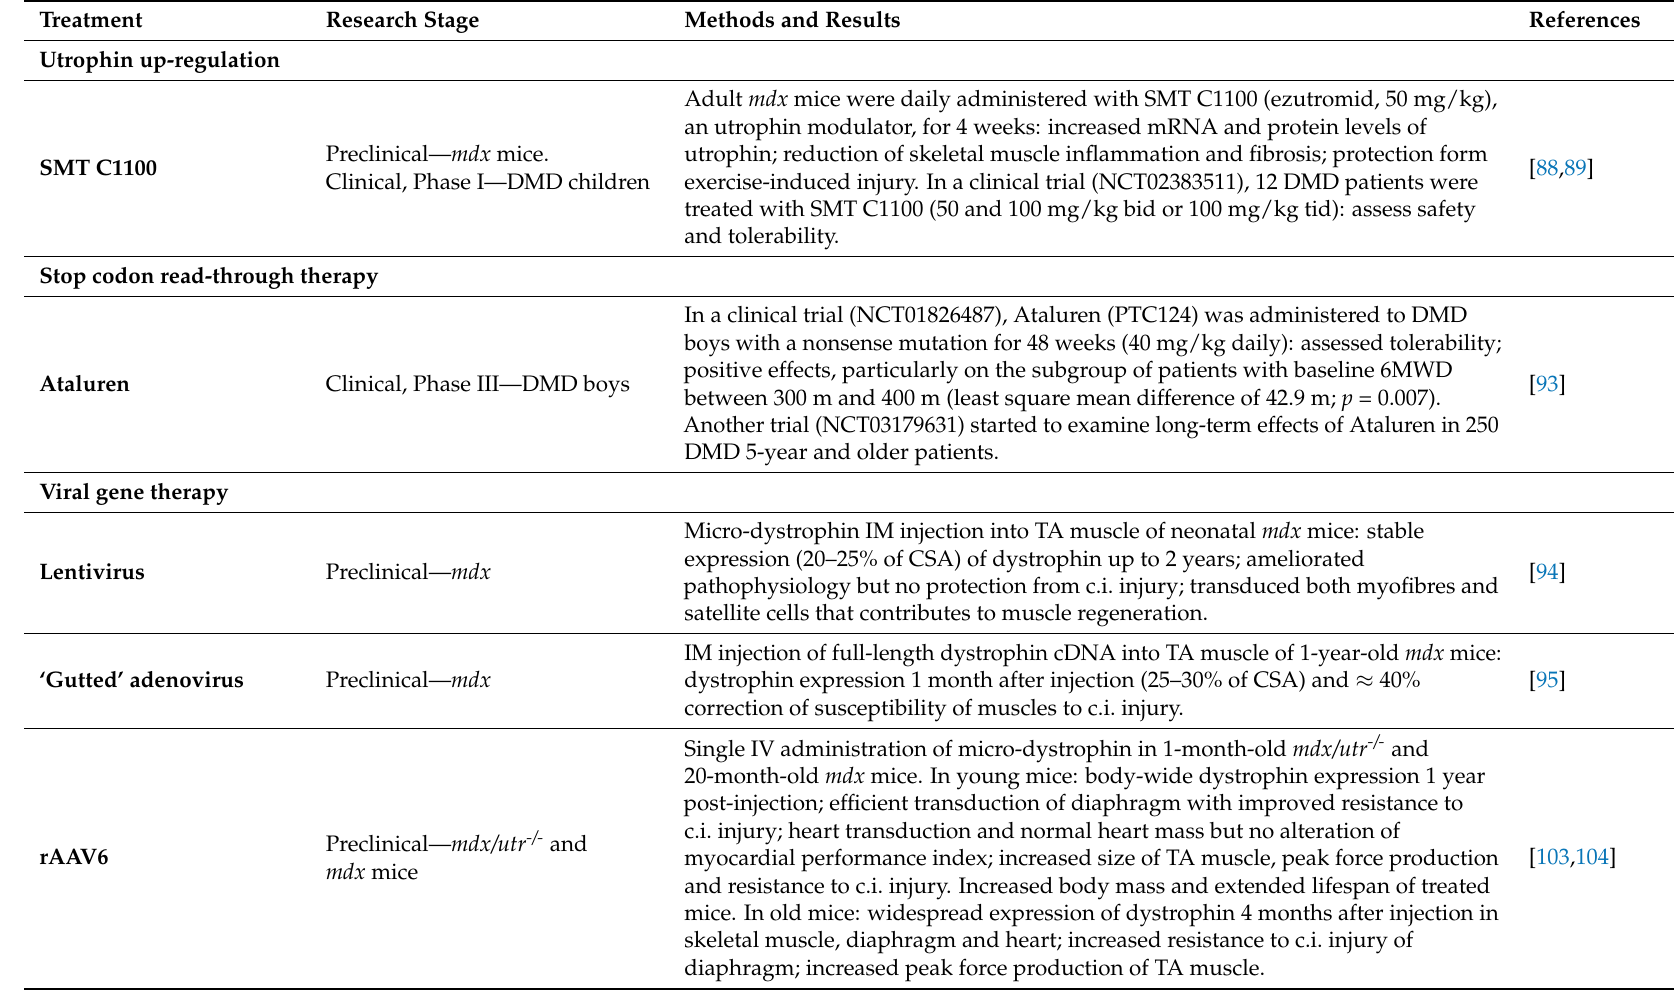
Table 1. Ongoing therapies to treat